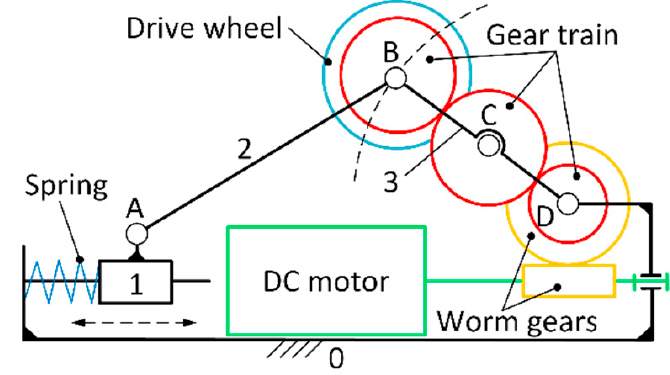
Figure 4. Schematic diagram of the adapting